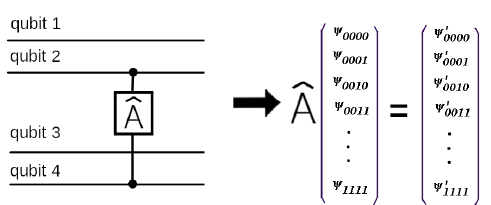
Figure 5. A 4-qubit quantum scheme with one 2-qubit operator ˆ A . To reproduce it on a quantum simulator we have to operate in the 16-dimensional Hilbert space (with 16-component vectors correspondingly). Here ˆ A acts on the qubits 2 and 4 and